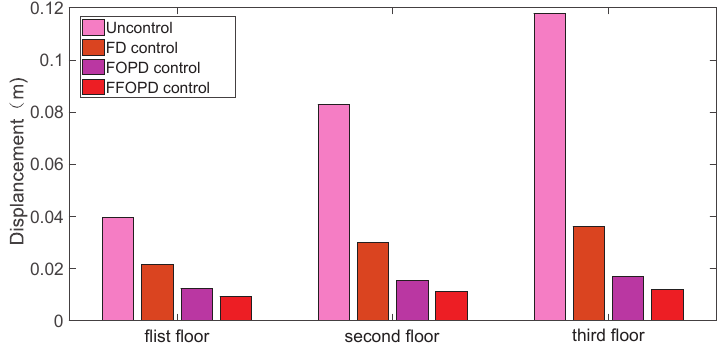
Figure 18. Maximum displacement of each floor under Taft